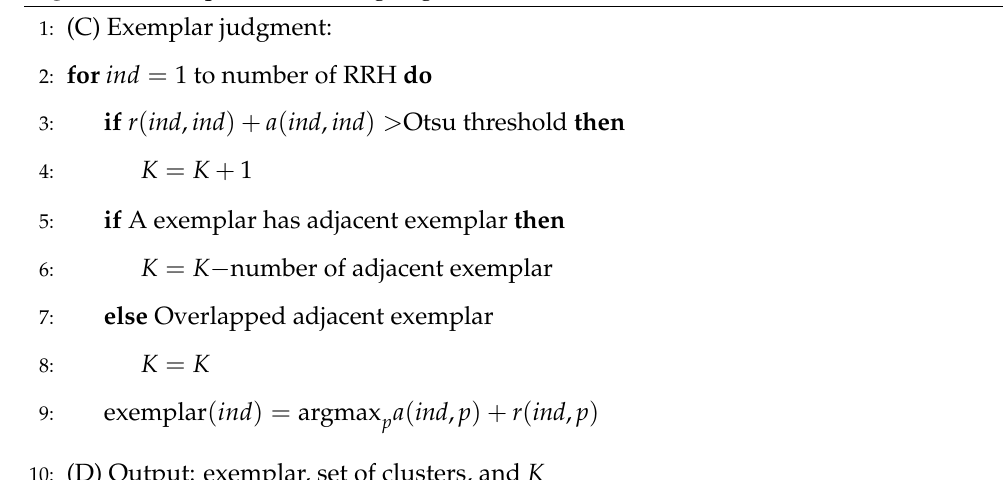
Algorithm 3 Proposed clustering Algorithm 2